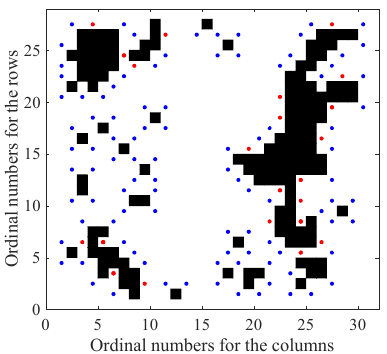
Figure 22. Distribution of key sampling points.